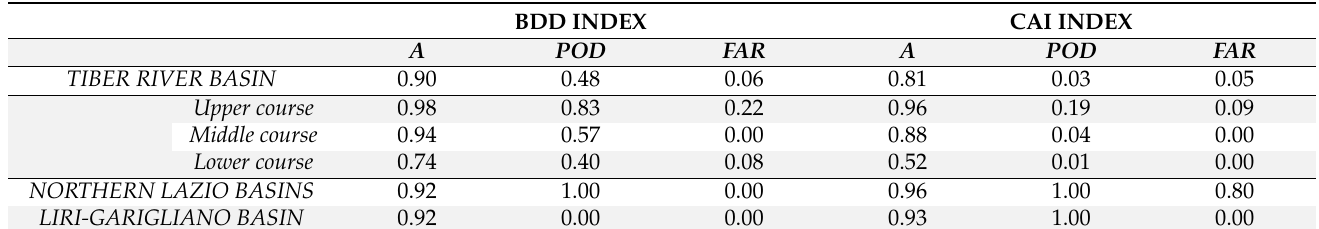
Table 4. Contingency table scores of BDD and CAI over the three investigated catchments.